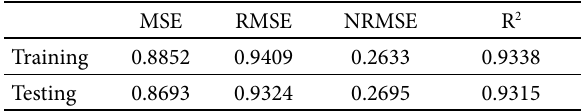
Table 9. The performance of GA-SVR model (scenario 3)